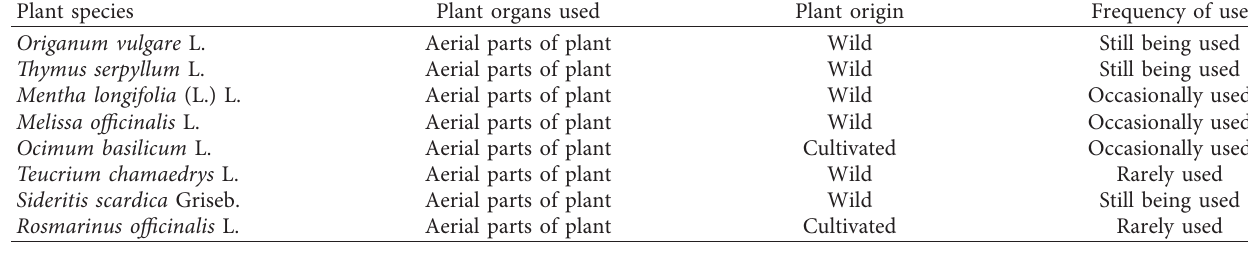
Table 2: List of the selected plant species used for tea preparation.